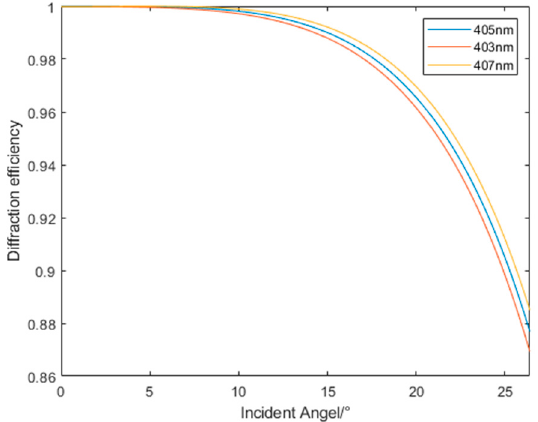
Figure 3. Diffraction efficiency of single layer DOE versus incident angle.